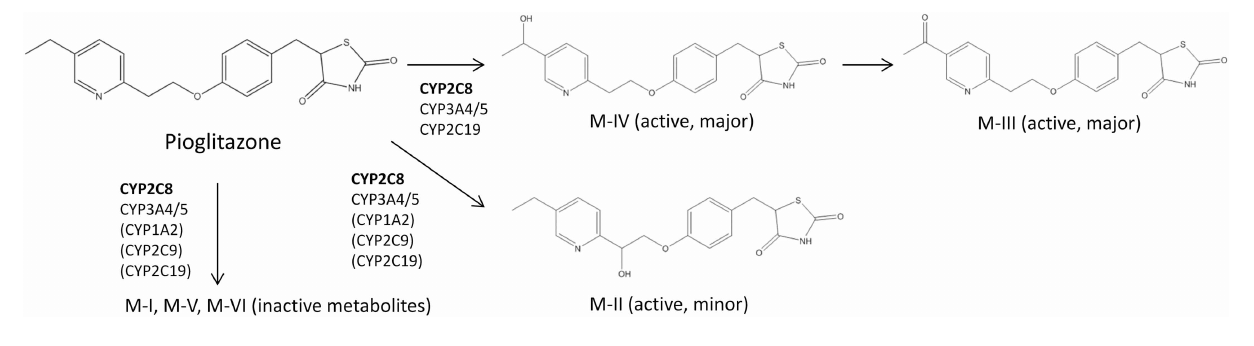
but their roles in the formation of particular metabolites are not clear according to currently available data (Eckland and Danhof, 2000; Jaakkola et al., 2006; Lai et al.,